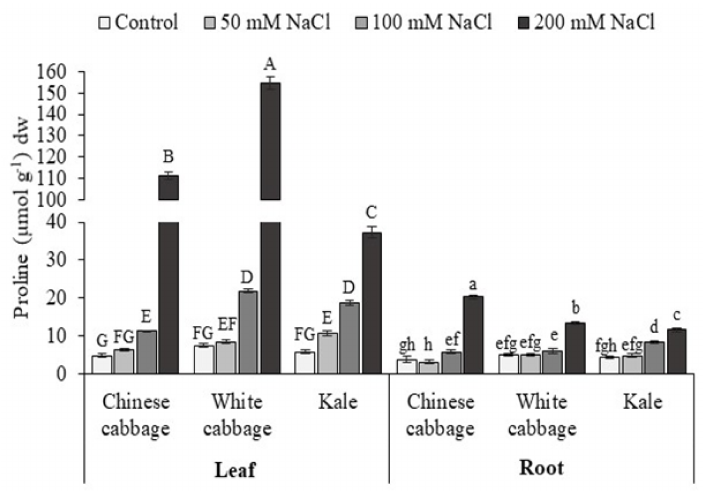
Figure 2. Proline level in Brassica leafy vegetables (Chinese cabbage, white cabbage, and kale) leaves and roots upon salinity treatments. Data labeled with different letters differed significantly at p < 0.05. Statistical analysis was performed among the three Brassica leafy vegetables, separately for leaves (capital letters) and roots (small